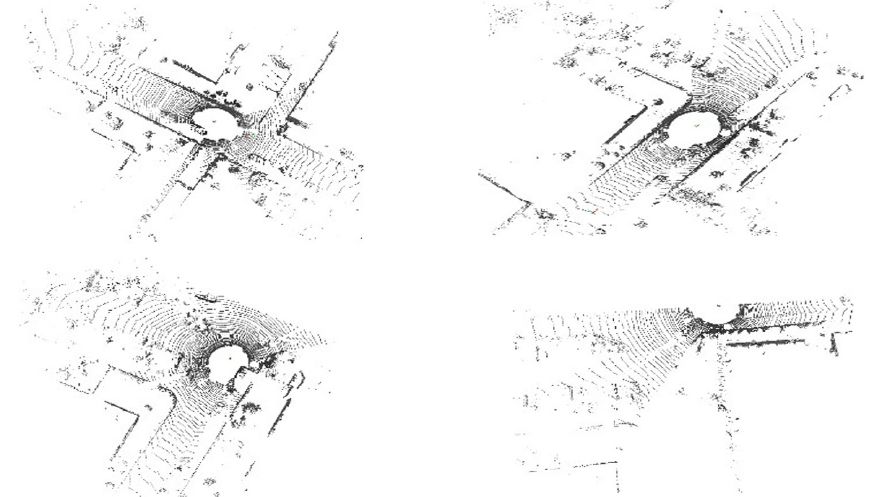
Figure 14. Original dataset.